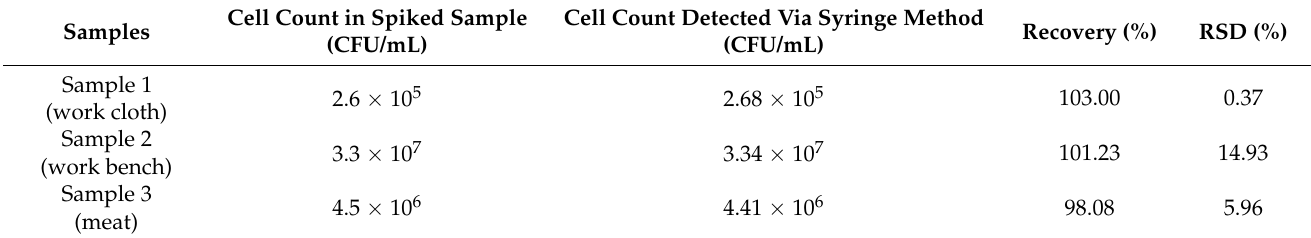
Table 2. Results of spike-and-recovery assay using syringe-based DNA extraction